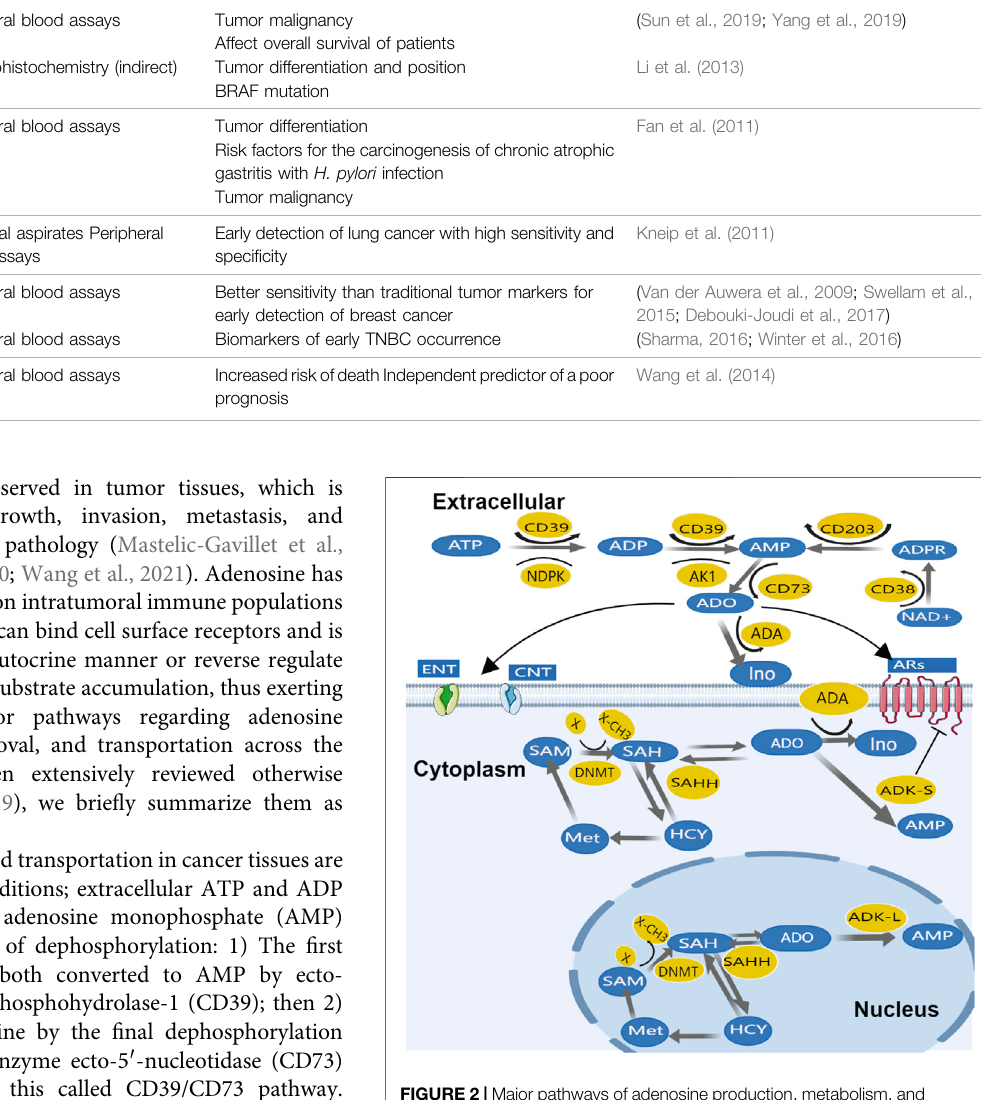
FIGURE 2 | Major pathways of adenosine production, metabolism, and